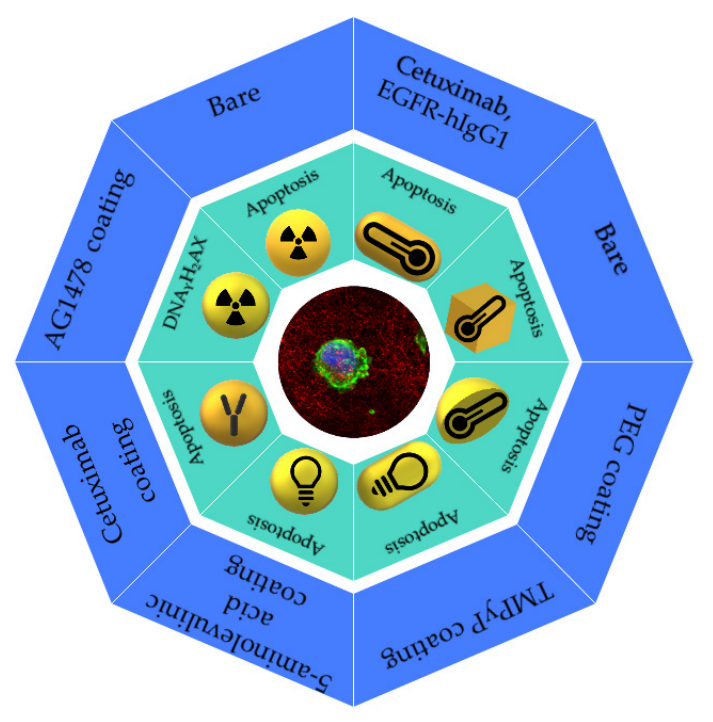
Figure 3. Scheme of several applications of functionalized AuNPs. The shapes (sphere, rhomboid, shell, and rod) and functionalization of the gold nanoparticles utilized in biomedical applications and their effects on cancer cells.